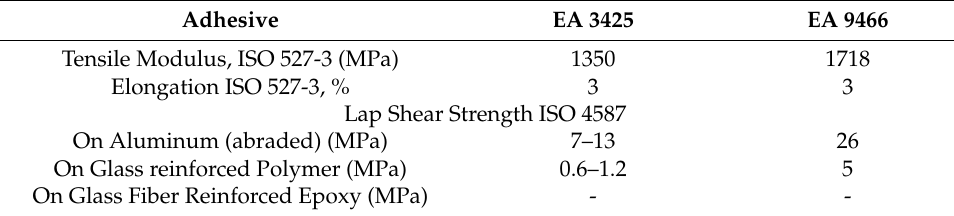
Table 2. Properties of adhesives used in the experiments taken from datasheets